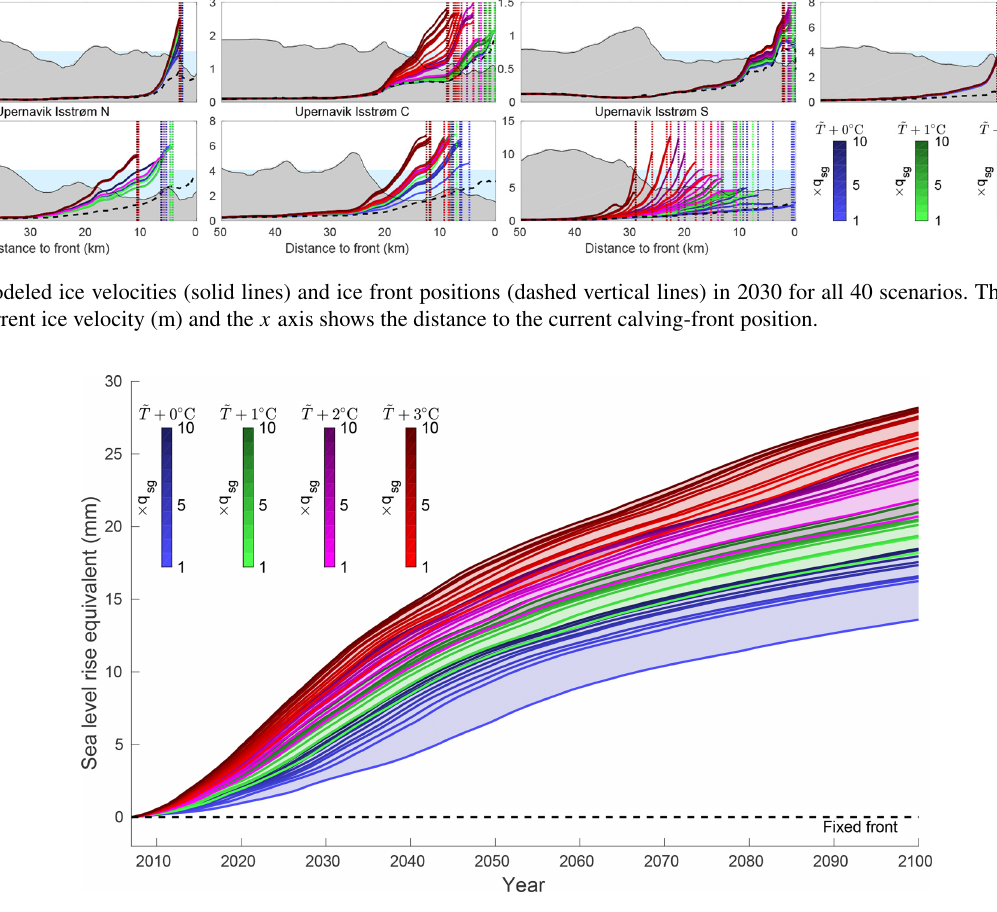
Figure 6. Contribution to sea level rise (mm) for all 40 scenarios. The black dashed line is the modeled contribution to sea level with a fixed calving front. All simulations rely on a constant surface mass